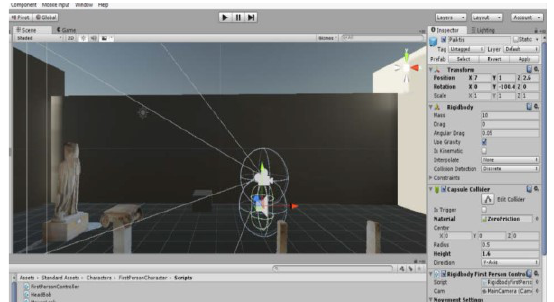
Figure 7: The main elements that configure the entity of visitor in the environment of